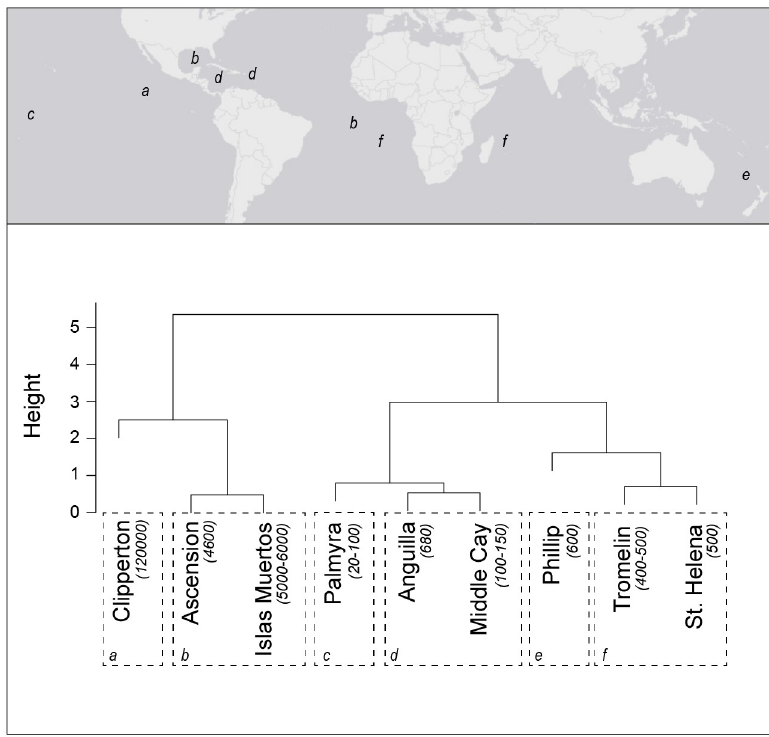
Fig 4. Hierarchical clustering analysis of global Masked Booby foraging effort derived from GPS tracking studies. Population estimates of breeding individuals are shown in italics, with letters identifying significant clusters and approximate locations. Height indicates the Euclidean distance between